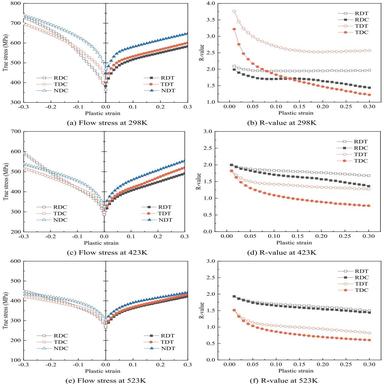
Flow stress and R-value of the α-Ti tube at different working temperatures show that the anisotropy and T-C asymmetry decrease with temperature.